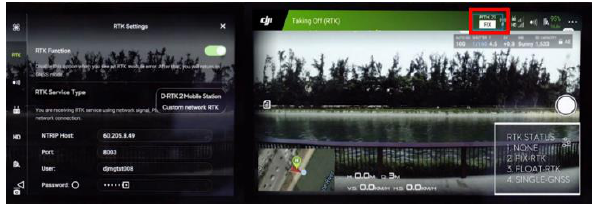
Figure 2. Definition of RTK settings in the GS PRO application (photo: